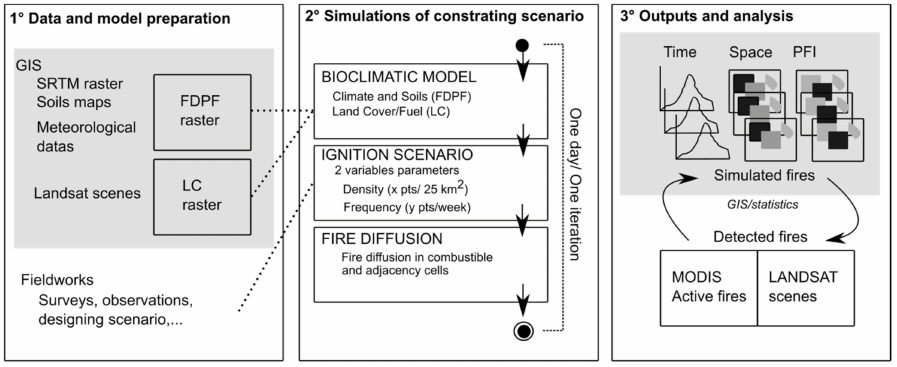
Figure 3. Procedures involved in one step (one day) of computer